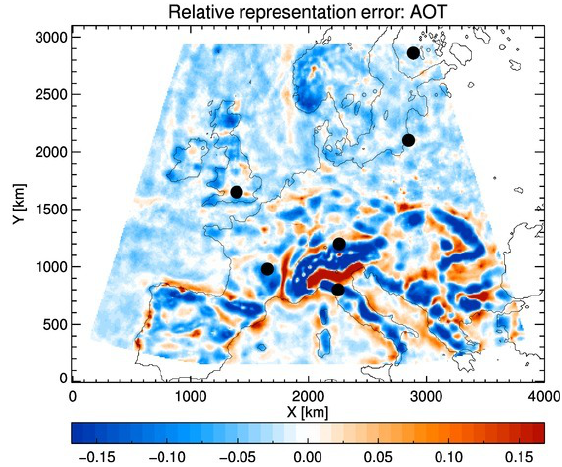
Figure 4. Relative representation errors in AOT in 6-month aver- ages. The represented area data were temporally collocated to the hour with the observations. The black dots show the locations of major ACTRIS measurement sites. Results for a 10 × 10km 2 ob- servation against a 210 × 210km 2 area.